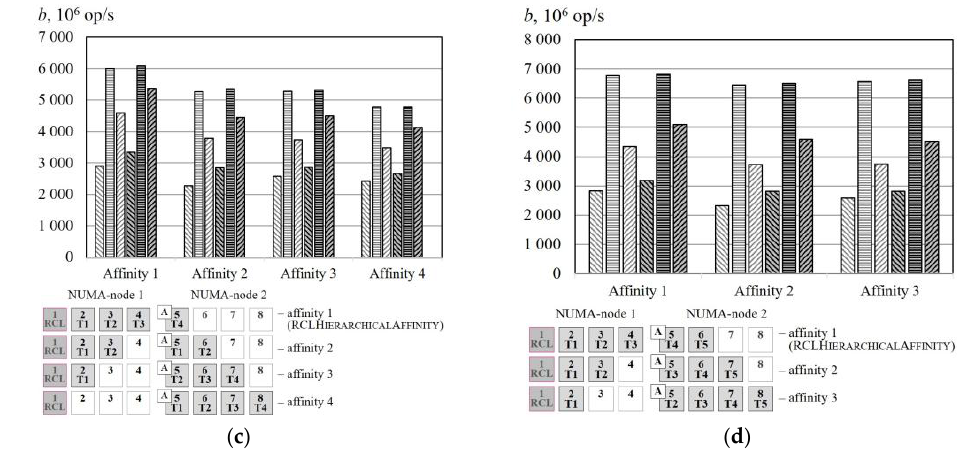
Figure 6. Thread affinity efficiency comparison, Oak cluster (NUMA system). ( a ) p = 2; ( b ) p = 3; ( c ) p